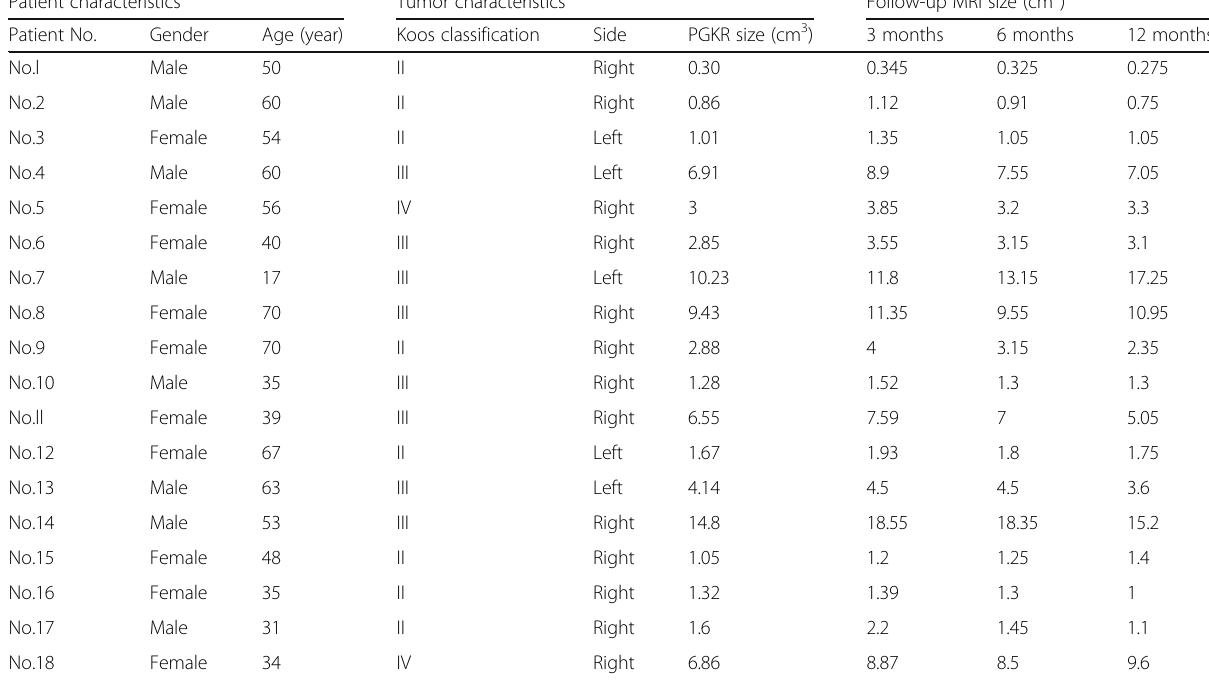
Table 2 Detailed patient data Patient characteristics Tumor